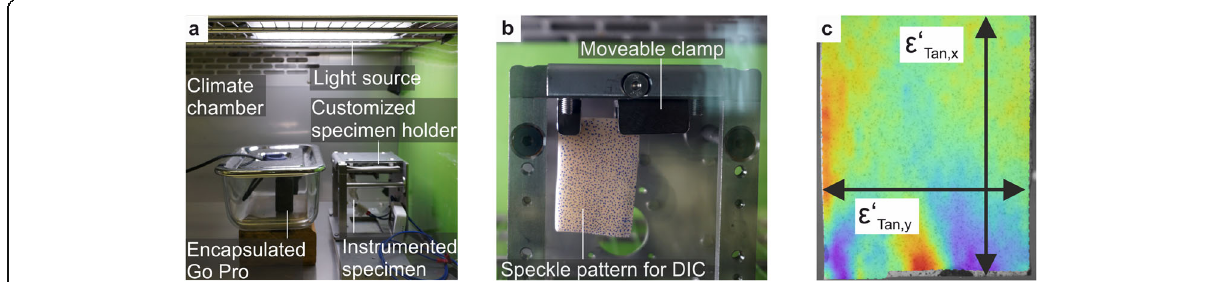
Fig. 2 a Test setup for actuation experiments in alternating climate chamber (MKF 115, Binder, Tuttlingen, Germany); b Cottonid specimen with speckled surface for strain measurements via digital image correlation (DIC) mounted in customized specimen holder; c Strain measurements on specimen ’ s surface via DIC parallel ( ε ’ Tan,x ) and perpendicular ( ε ’ Tan,y ) to manufacturing